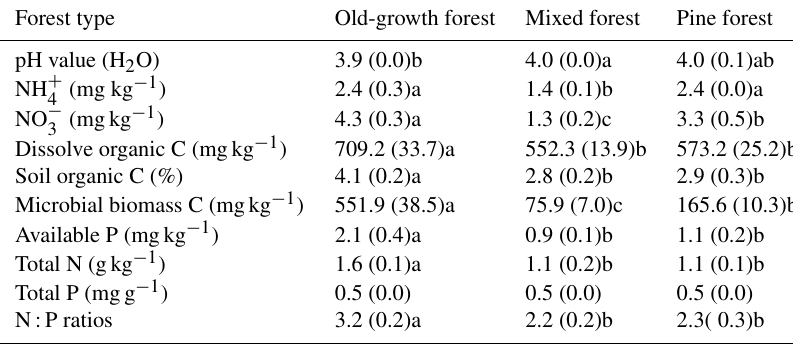
Table 1. General characteristics of the 0–10cm mineral soils in the three study